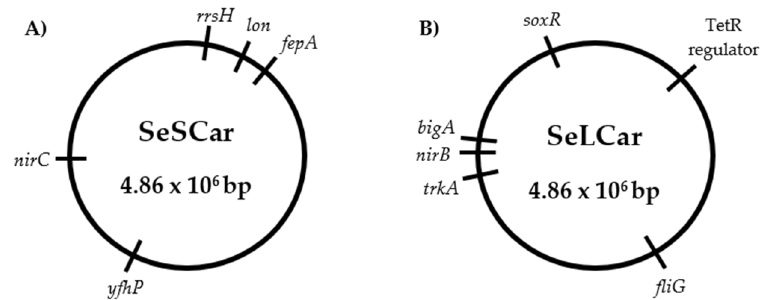
Figure 6. Genomic maps of the Salmonella enterica subsp. enterica serovar Typhimurium LT2 evolved strains by cyclic exposure to prolonged sublethal treatments (SeSCar; ( A )) and to short lethal treatments (SeLCar; ( B )) of carvacrol.